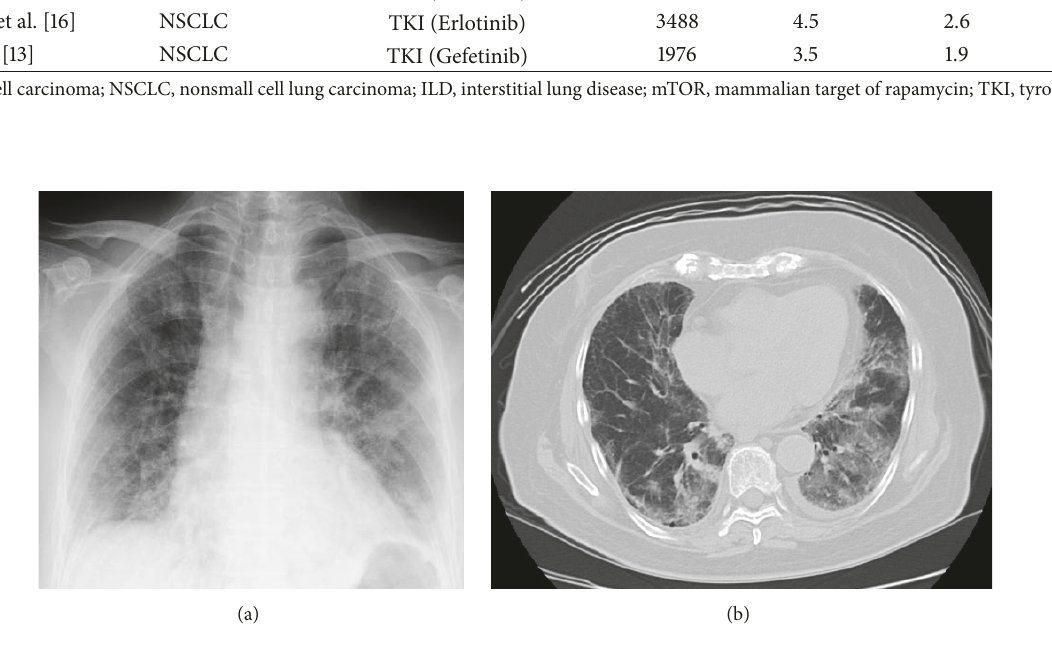
Figure 2: (a) Chest X-ray two months after starting everolimus administration, showing diffuse infiltrative shadows in both lung fields. (b) Chest CT scan two months after starting everolimus administration, showing ground-glass attenuation with diffuse alveolar consolidation in both lung